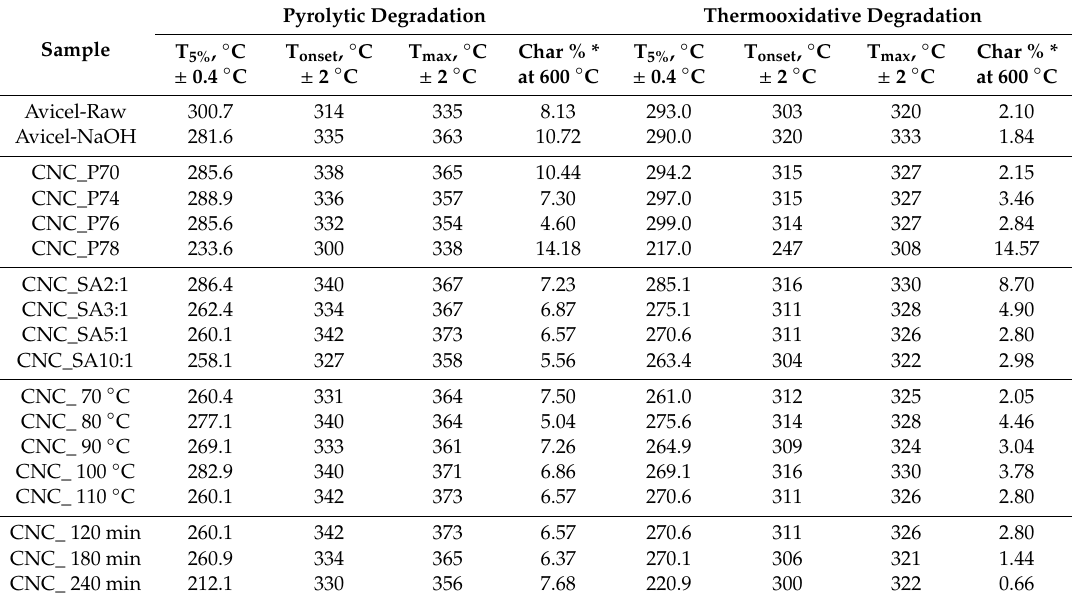
Table 3. Parameters of pyrolytic and thermo-oxidative degradation of cellulose materials.